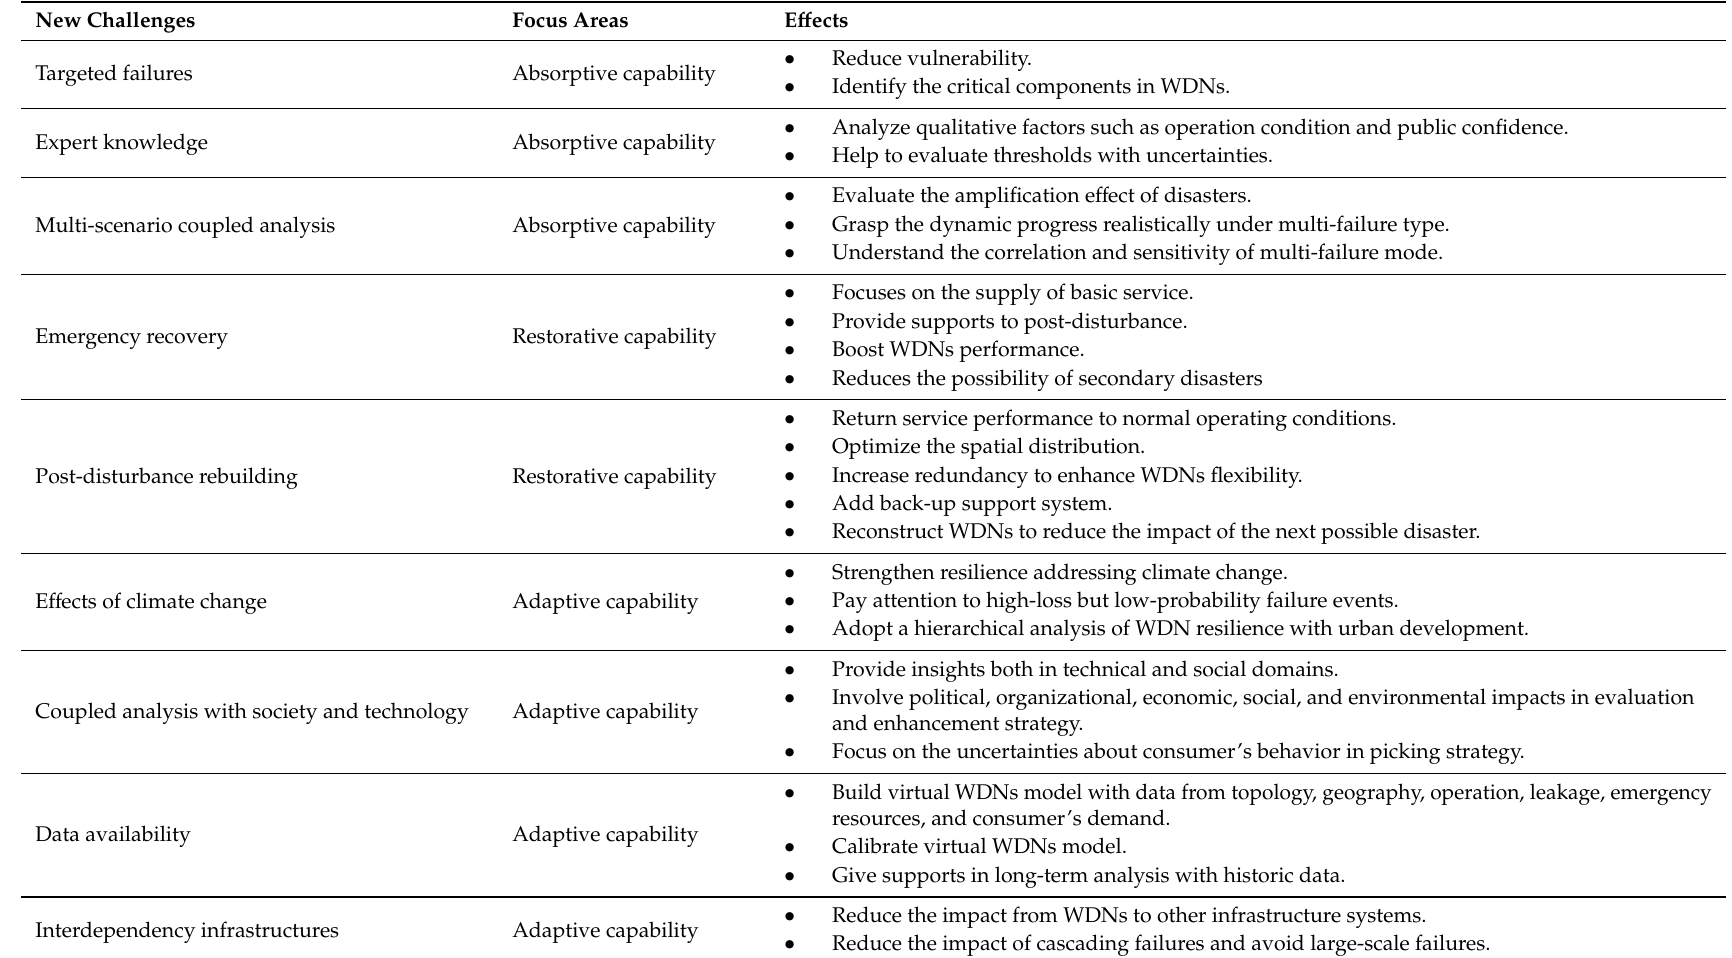
Table 2. New challenges with resilience capability